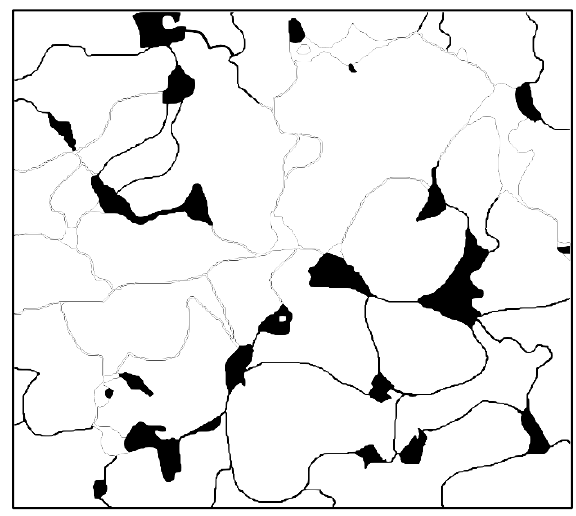
Figure 17. Oil and water distribution before adjustment.